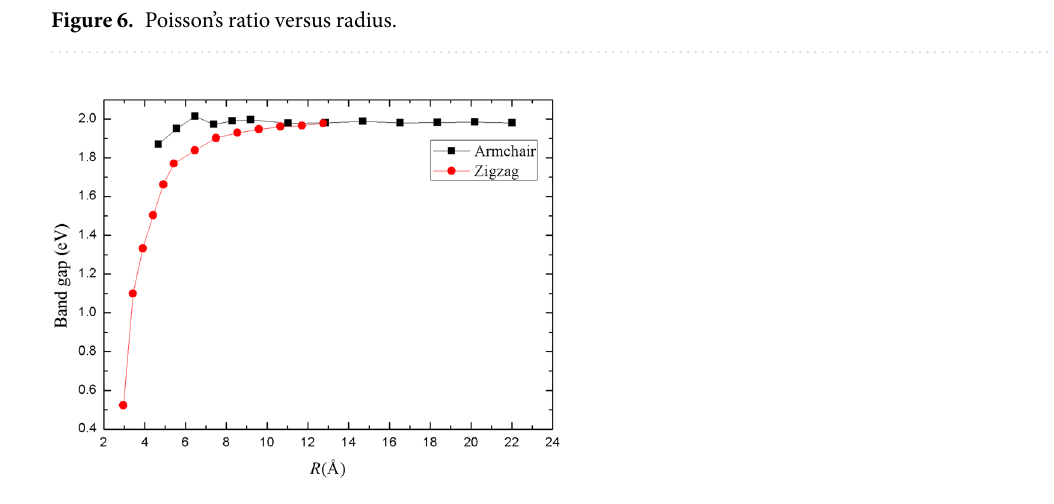
Figure 7. Band gap versus